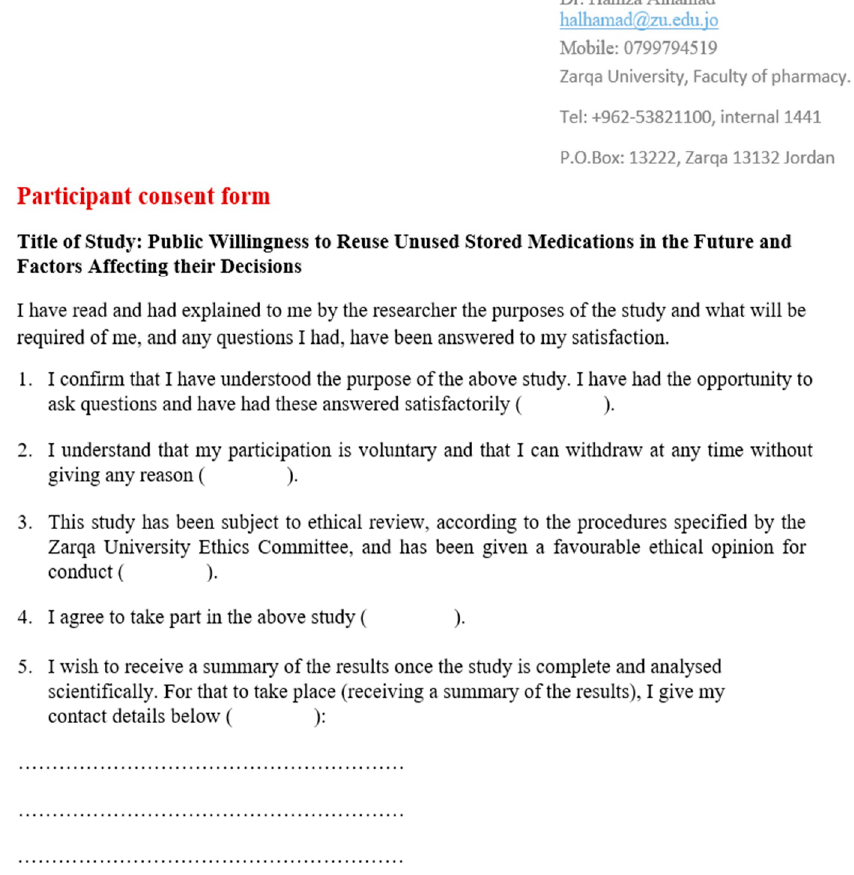
Figure A2. Participant Consent Form.